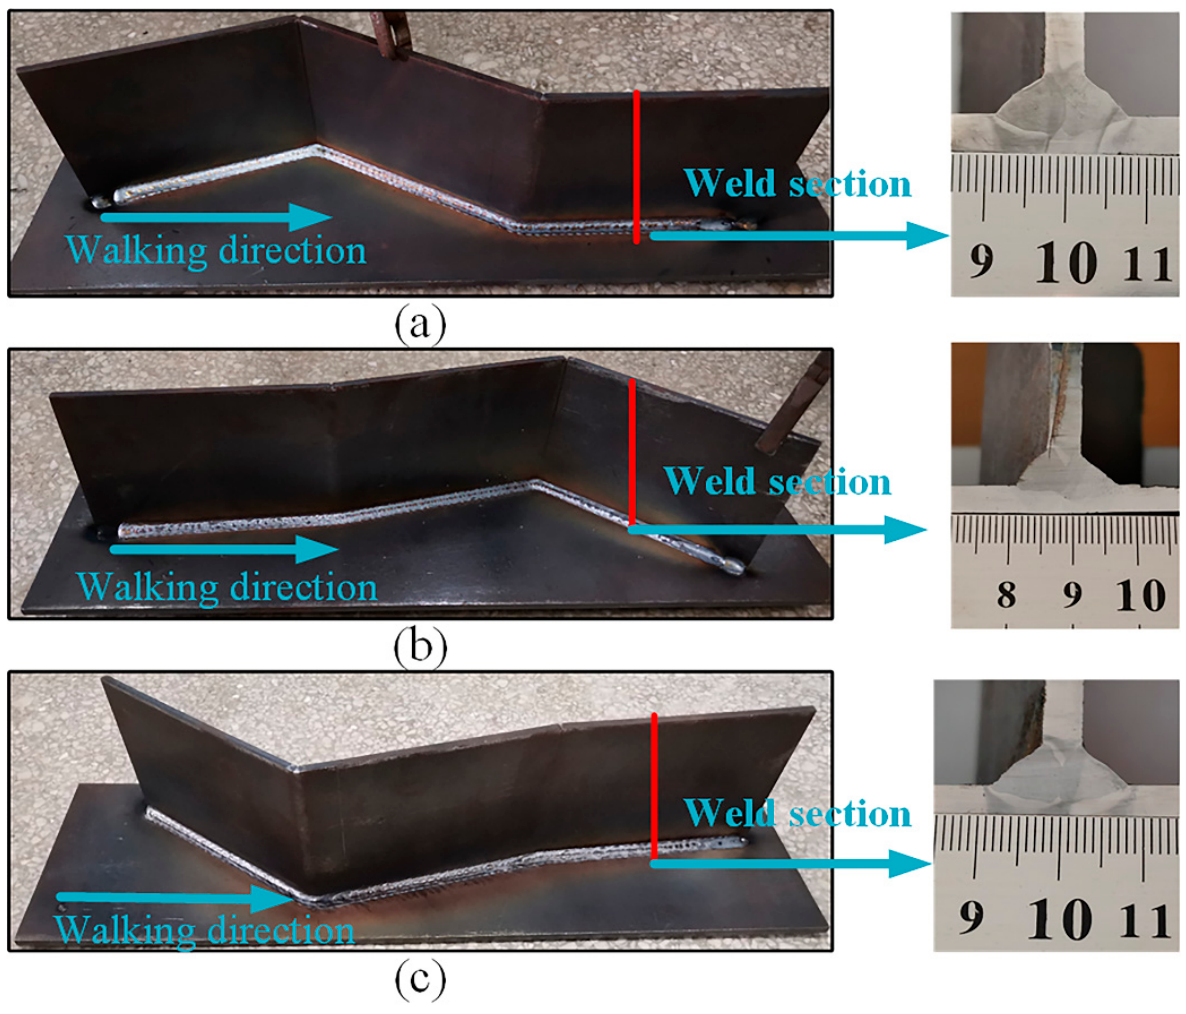
Figure 14. Real-time tracking results of 3D zigzag-line welding seams; ( a – c ) The real-time tracking results of 3D zigzag-line welding seams with fold angles of 130°, 150°, 170°, 180°, 190°, 210° and 230°.